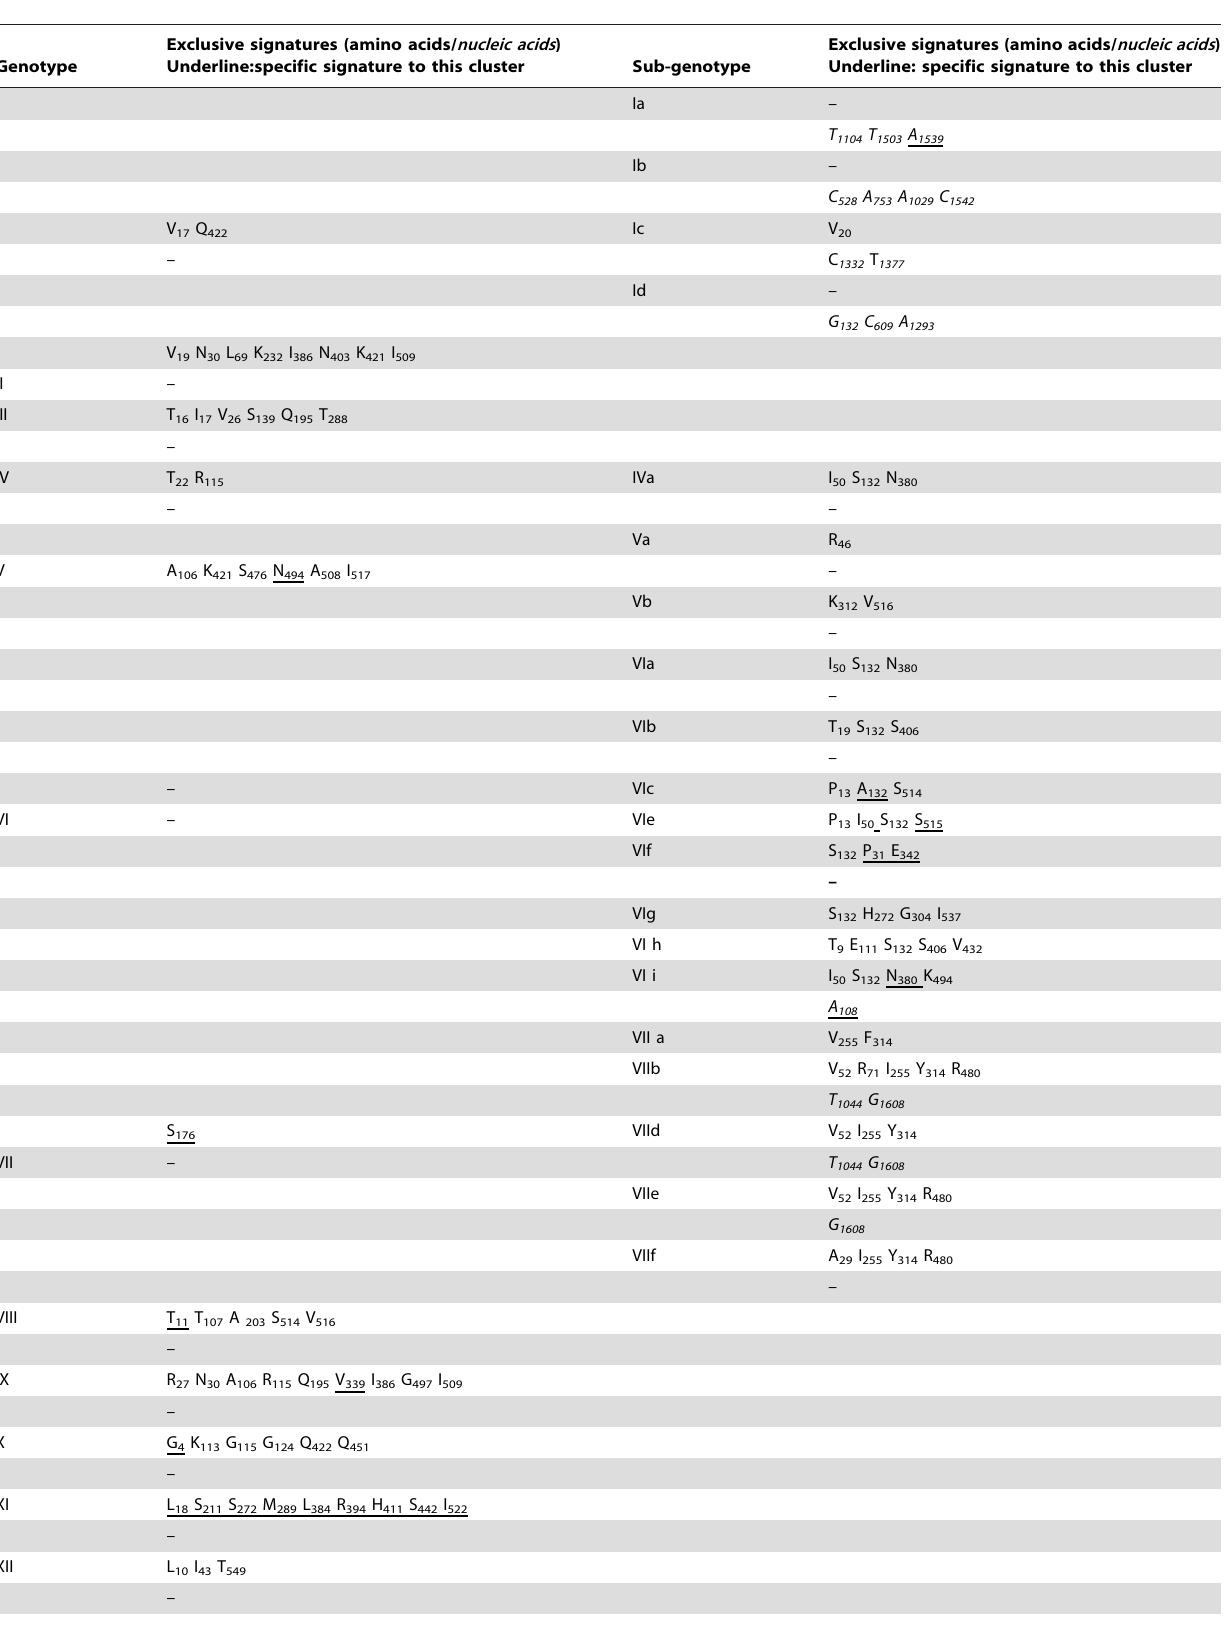
Table 5. List of specific signatures on the F complete gene for genotypes and subsequent sub-genotype discrimination.